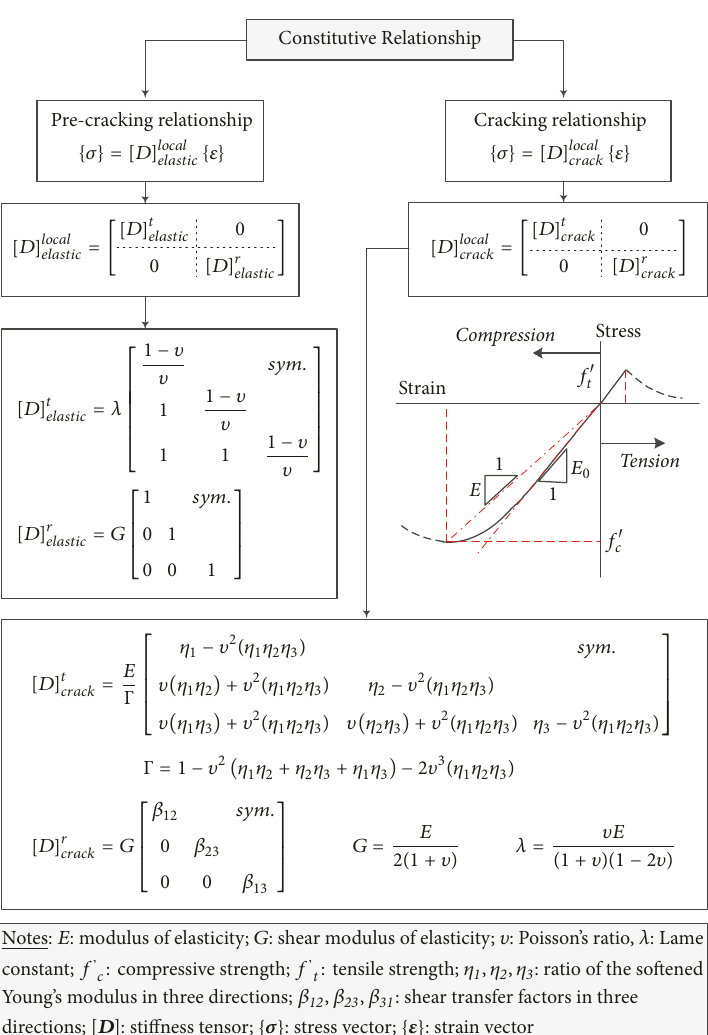
Figure 2: Constitutive model for the concrete based on coaxial rotating smeared crack model; adopted from [6].